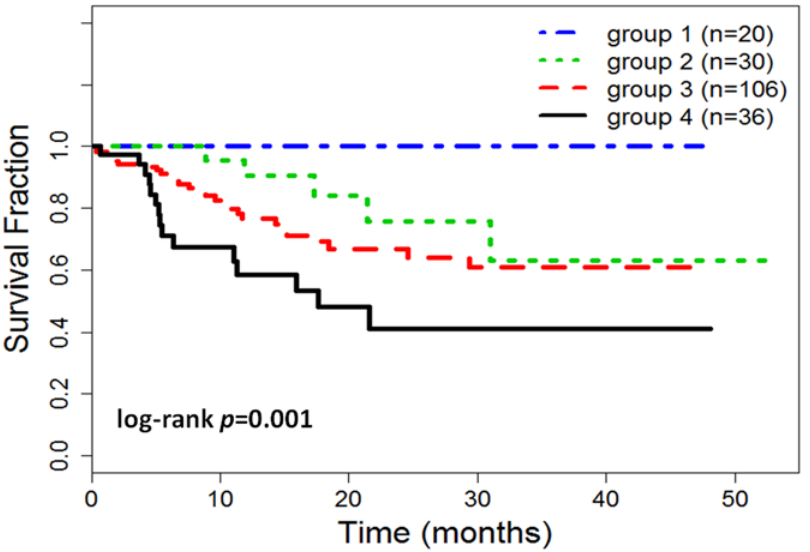
Fig 3. Kaplan Meier curves of disease free survival of risk groups for TNBC patients. The patients were stratified into different risk groups. Two low basal (EGFR (cid:1) 15% and CK5/6 (cid:1) 50%) risk groups: group 1 (n = 20) with low expressions/values of EGFR ( (cid:1) 15%), CK5/6 ( (cid:1) 50%), Ki-67 ( (cid:1) 50%), pT ( (cid:1) 3), and pN ( (cid:1) 1), and group 2 (n = 30) with low expressions of EGFR and CK5/6, and any high expressions/values of Ki-67, pT, and pN. Two high basal risk groups: group 3 (n = 106) with single high basal expression (EGFR > 15% or CK5/ 6 > 50%), and group 4 (n = 36) with double high basal expressions (EGFR > 15% and CK5/6 > 50%).